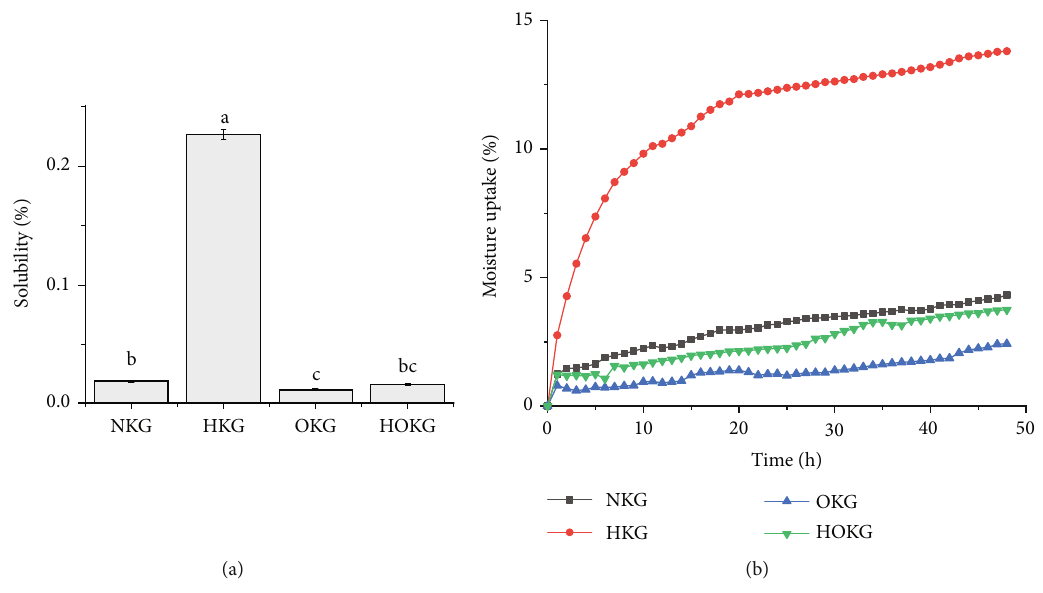
Figure 4: Solubility (a) and moisture uptake (b) of KG powders.